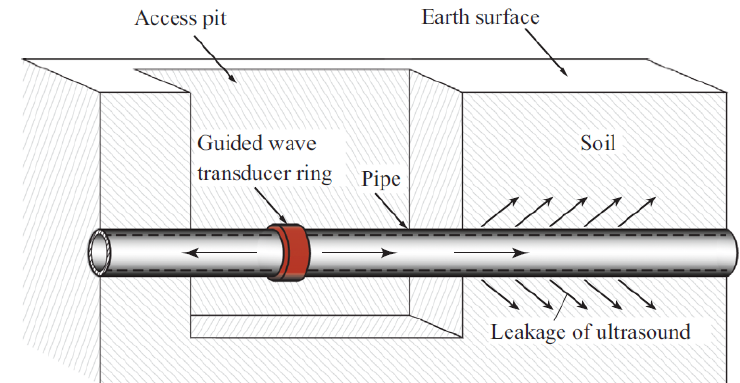
Figure 4. An ultrasonic transducer ring mounted onto an excavated pipeline to perform guided wave inspection. Reprinted under Creative Commons CC BY license